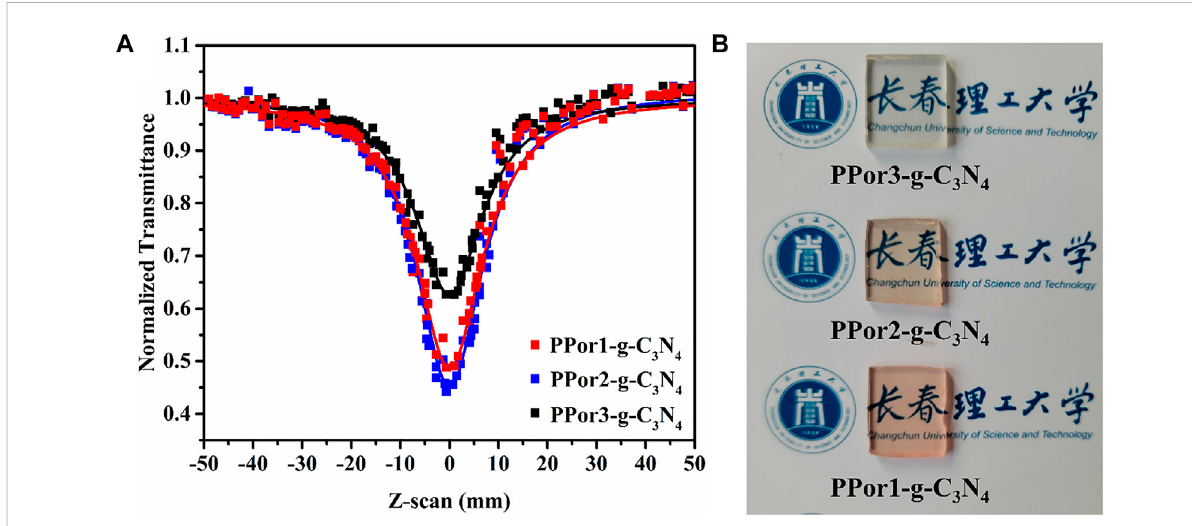
FIGURE 10 (A) The open aperture Z-scan tests of PPorx-g-C 3 N 4 /PMMA composites with the doping concentration of 0.05 mg/ml. (B) Photographs of PPorx-g-C 3 N 4 /PMMA composites with 0.05 mg/ml doping concentrations.